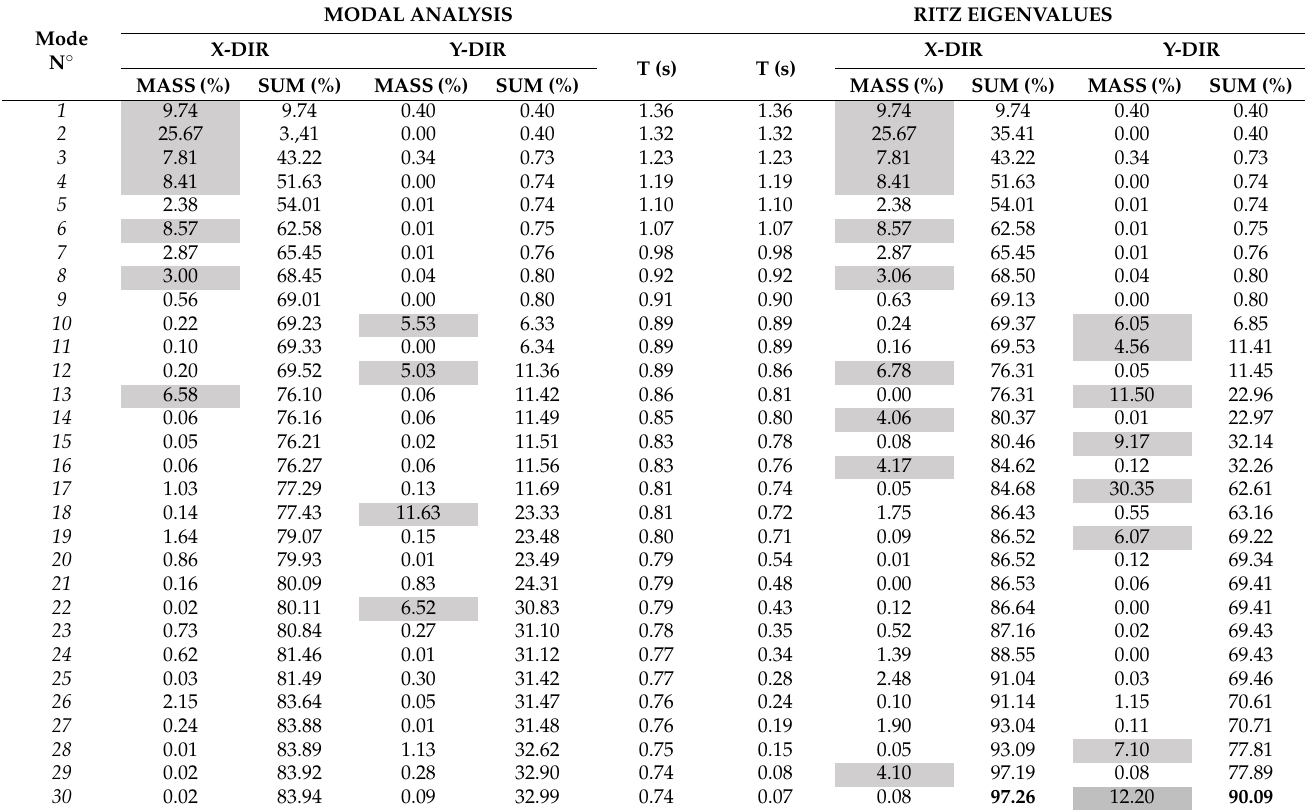
Table 6. Summary of the results obtained for the modal analysis and the Ritz